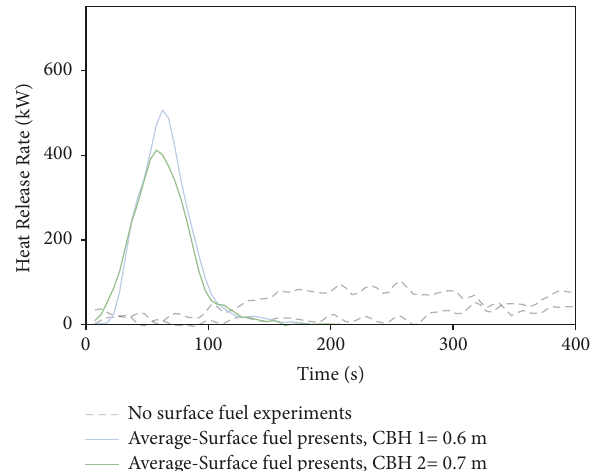
Figure 9: Crown fire behavior of wind-driven experiments con- ducted with a surface fuel bed (solid lines) and without a surface fuel bed (dashed lines).